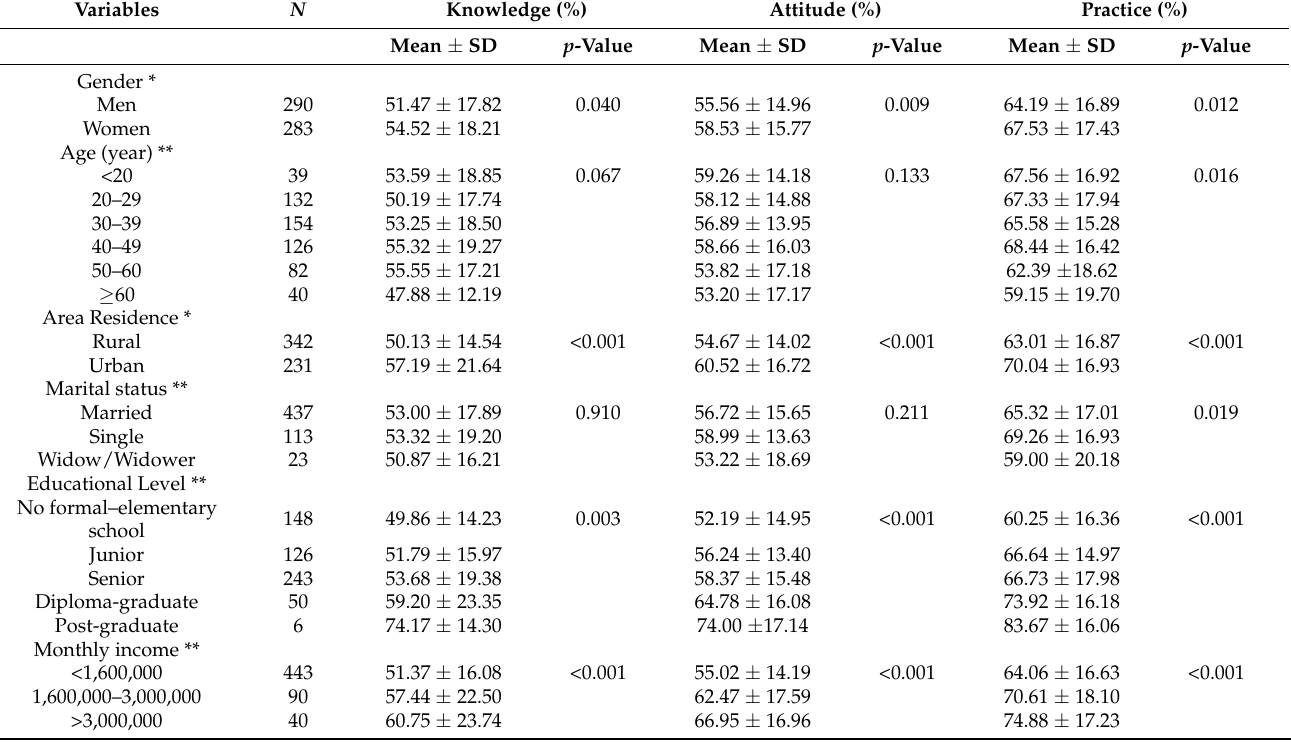
Table 4. Association of demographic characteristics and knowledge, attitude, and practice based on univariate